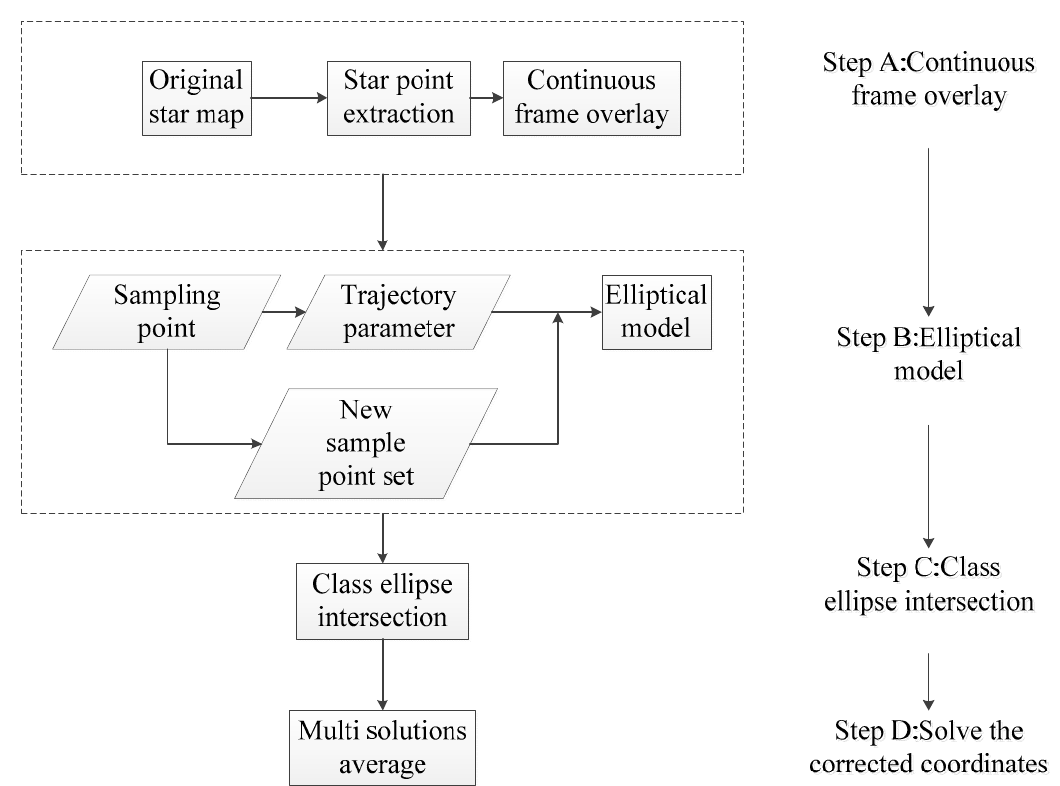
Figure 1. The flow chart of the ellipsoid model method.